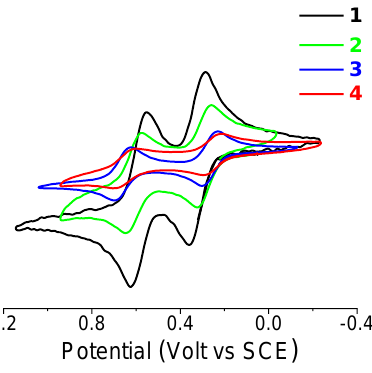
Figure 6. Cyclic voltammetry of the 1 – 4 series in CH 2 Cl 2 containing 0.1 M n Bu 4 NPF 6 as the supporting electrolyte (Au disk electrode ( d = 0.5 mm); scan rate 0.2 Vs − 1 ; T = 20 °C). The current i is normalized according to the equation iv − 1/2 c − 1 , to account for diffusion-controlled current variation, with concentration c in the range 0.9 – 2.7 mM.